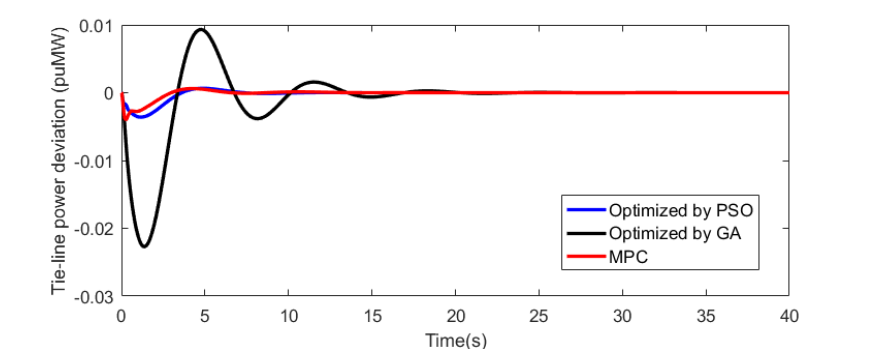
Figure 12. Tie-line power deviation for the second